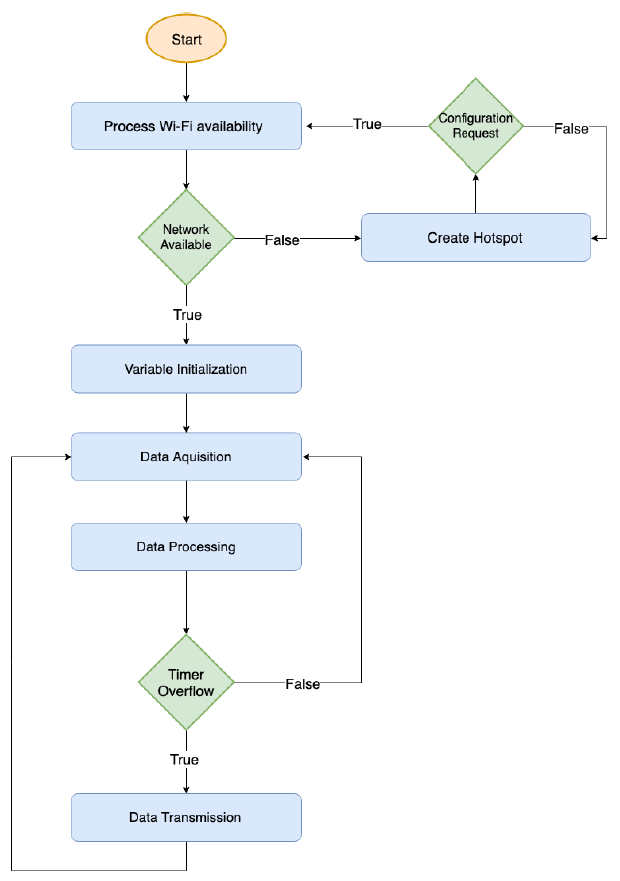
Figure 4. Flow diagram of the acquisition module.